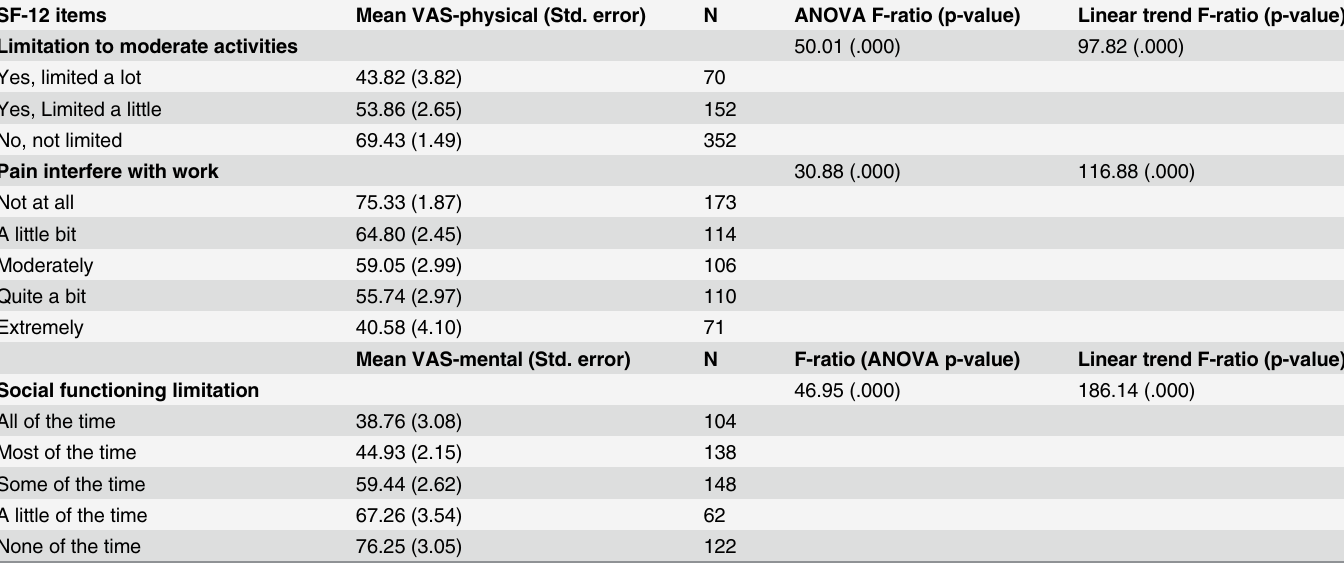
Table 6. SF-12 items by mean visual analogue scale score, ANOVA, and test of linear trend results. SF-12